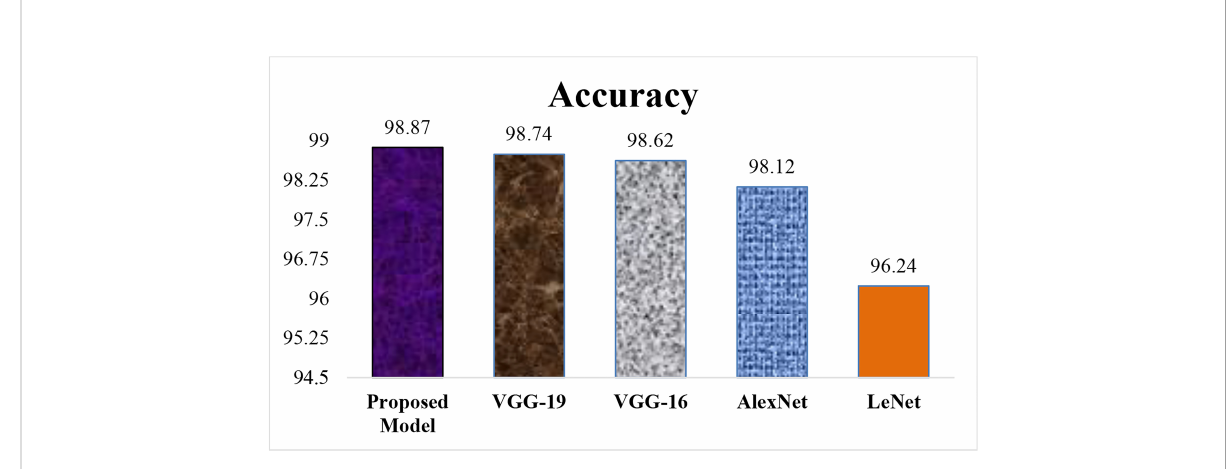
FIGURE 15 Accuracy (%) of different